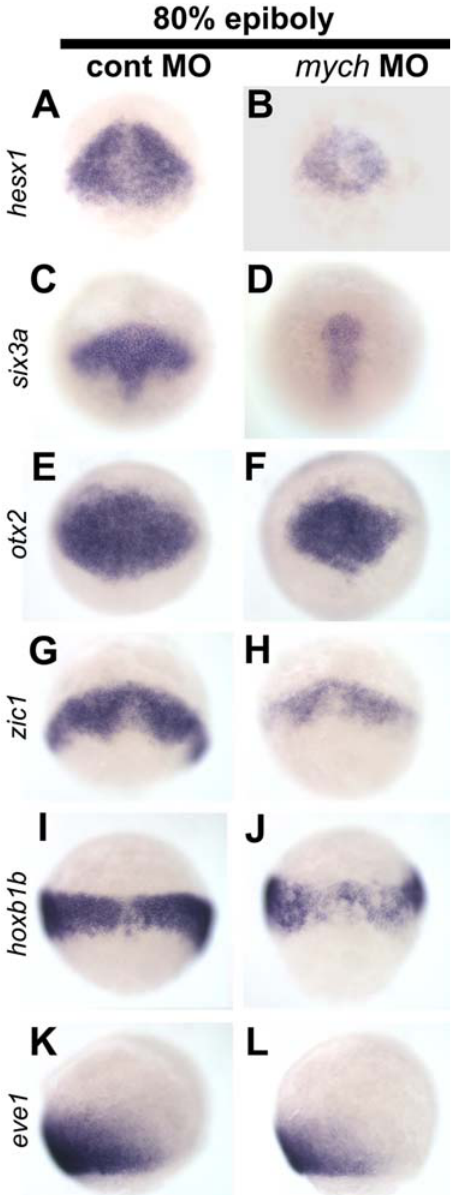
Figure 5. Reduced expression of early anterior brain markers after mych MO injection. A–J. Dorsal views (A–J) and lateral views (K–L) of control MO-injected (A,C,E,G,I,K) and mych UTR MO-injected embryos (B,D,F,H,J,L) at the 80% epiboly stage. The probes are indicated. doi:10.1371/journal.pone.0002029.g005 (Fig. 4I,J). Further, these markers suggest a widening of the axis, as also seen in unstained embryos (Fig. 3B). Such widening was further illustrated by using probes that label the polster (future hatching gland; ctsl1b), neural plate boundary and placodal anlage (dlx3b ), the notochord ( ntl ), and early somites ( pcdh8/papc ). All of these markers were expressed in approximately normal patterns in the experimental embryos except that a widened axis was seen in 82% (n= 89) of mych MO-injected embryos, whereas 92% (n= 45) of control MO-injected embryos were normal (Fig. 4K–N). This axis abnormality was fully rescued by coinjection of mych mRNA (85% normal, n =80) (Fig. 4O,P).